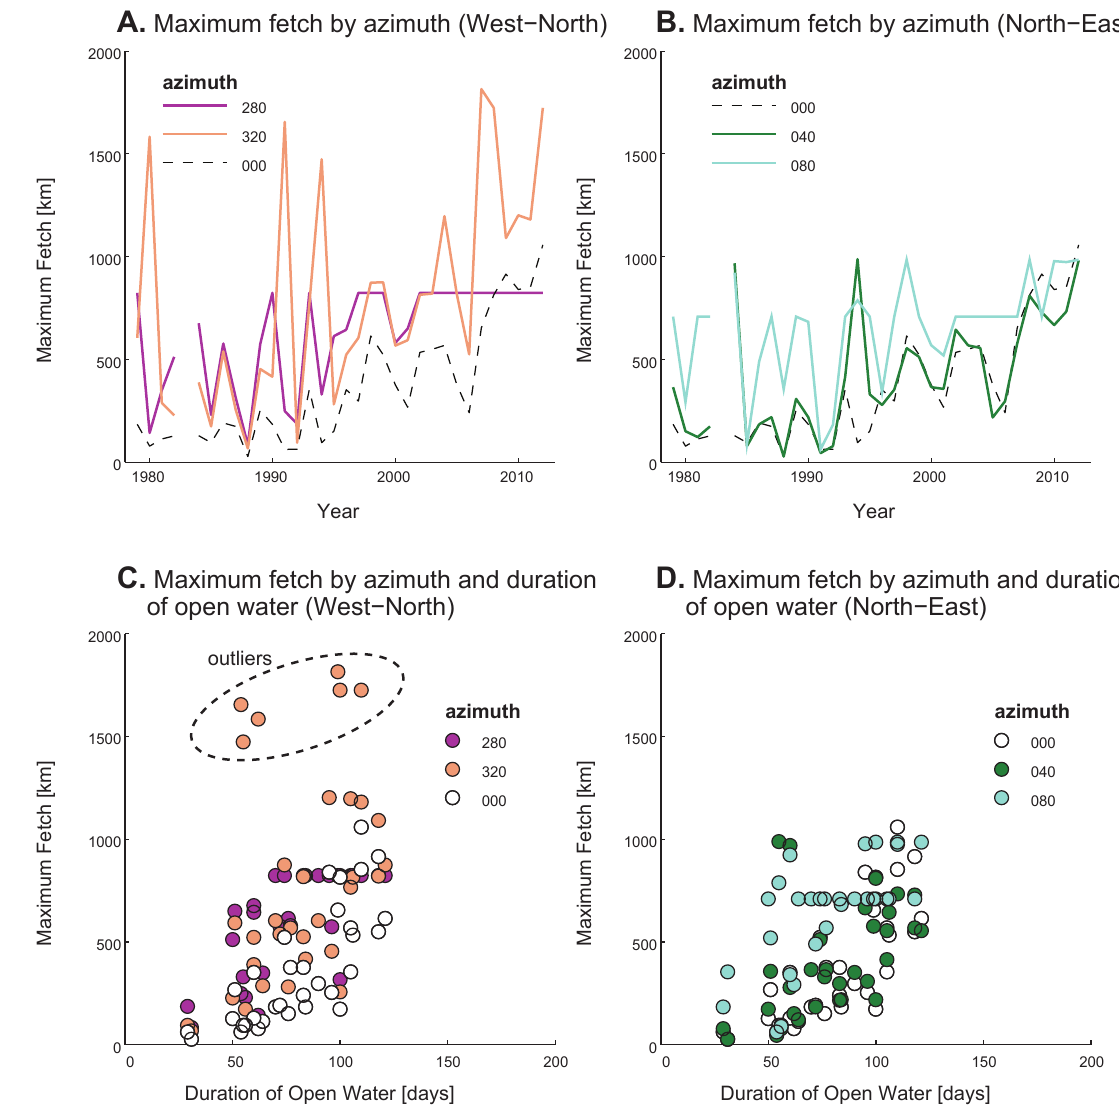
Figure 8. Maximum distance to the sea-ice edge (fetch) as a function of azimuth and time for west (a) and east (b) azimuths and a function of azimuth and duration ( c and d ). The maximum fetch has increased over the observation period and is typically greater in the west than in the east. The fetch to the west (azimuth 270) reaches a maximum at just under 800km when it reaches Wrangel Island in the Chukchi Sea. There is a positive relationship between the length of the open-water season and the maximum fetch ( c and d ). The maximum fetch to the northwest (azimuth 330) has the least well-defined relationship with duration of open-water conditions ( c , light purple dots). This is a direction from which wind sets water levels up at the coast (Fig.